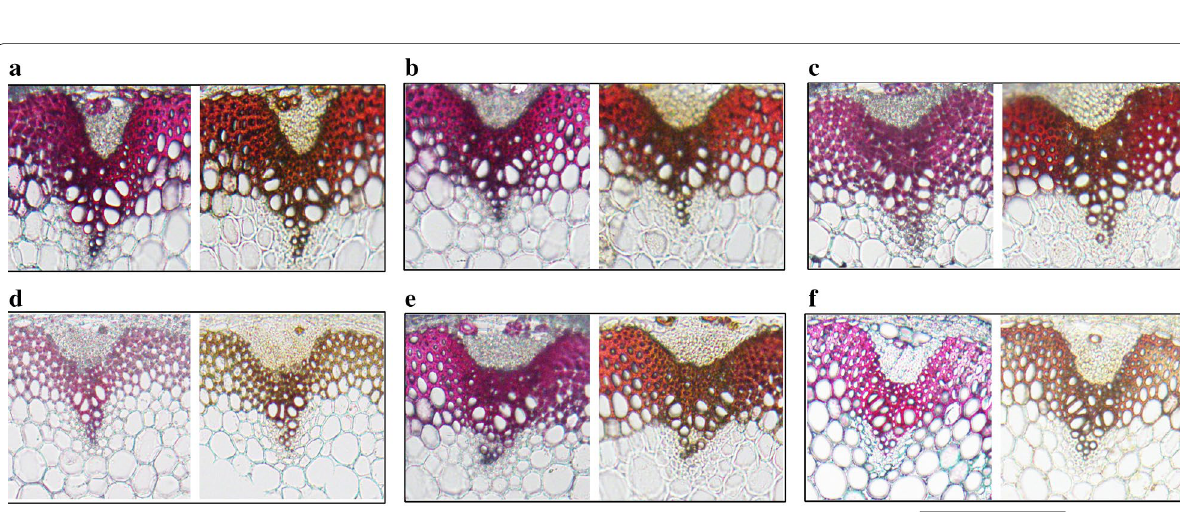
role in the part of the phenylpropanoid pathway lead- ing to the G and S units after the branching off of H unit biosynthesis (Vanholme et al. 2013). The mutant